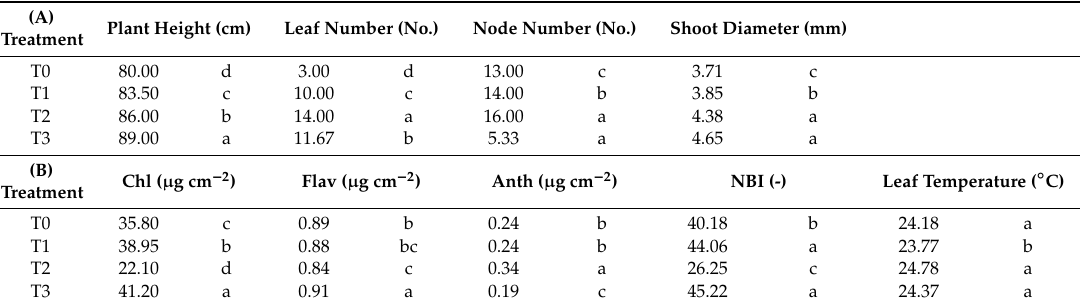
Table 3. Morphological (A) and Physiological (B) parameters recorded on bare-rooted vines measured at 314 day of the year (DOY).